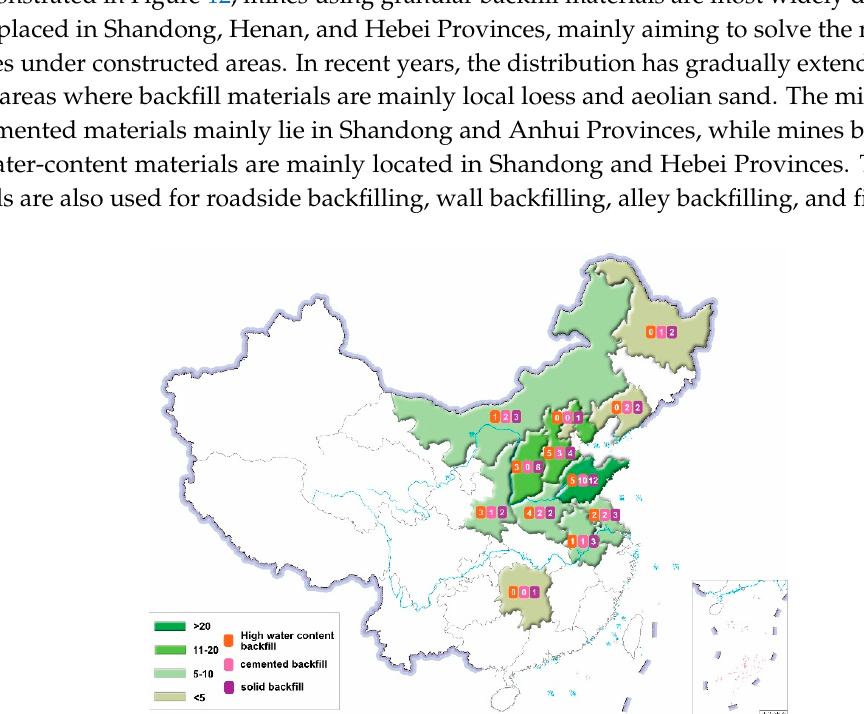
Figure 12. Distribution of mines and their backfill mining techniques.